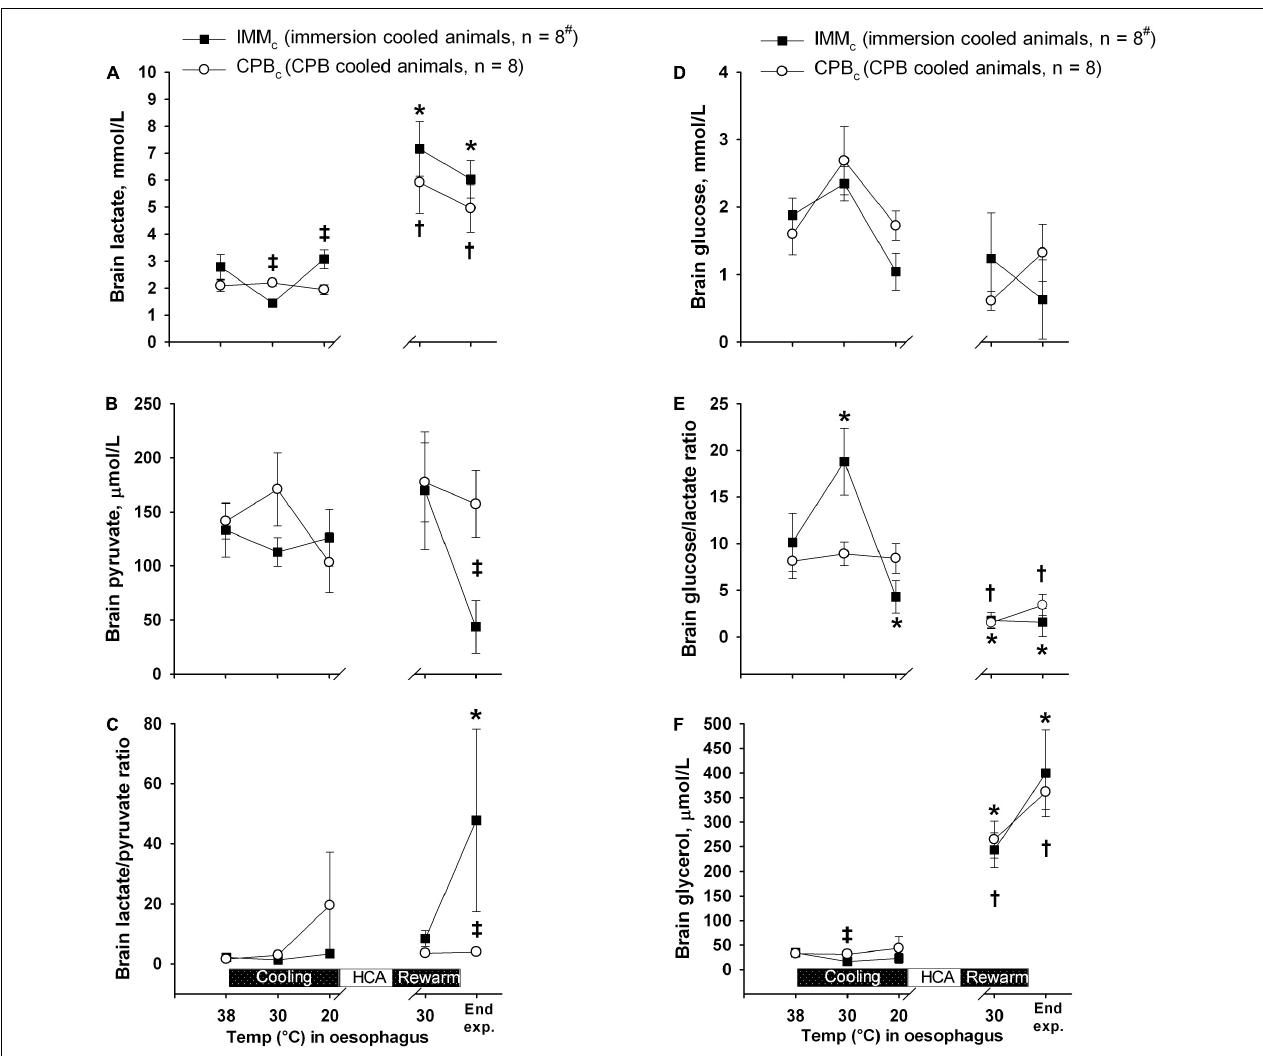
FIGURE 5 | Brain microdialysate analyses. (A) Brain lactate. (B) Brain pyruvate. (C) Brain lactate/pyruvate ratio. (D) Brain glucose. (E) Brain glucose/lactate ratio. (F) Brain glycerol. Data presented as mean and SEM. *Statistically significant difference from baseline within IMM c group, and † within CPB c group ( p < 0.05). ‡ Statistically significant difference between groups ( p < 0.05). # n was reduced to 5 animals after termination of CPB (Post CPB) and to 4 animals at end of experiments (End experiment) in IMM c